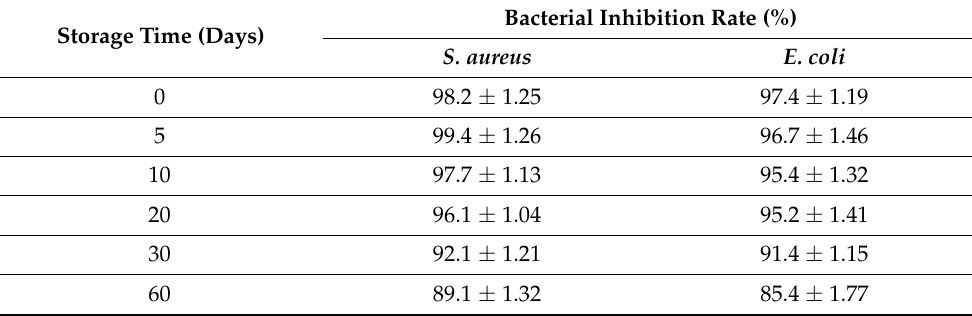
Table 7. Antibacterial activity of 100% HPMC-based CS–SiNPs-encapsulated PO-PE against Staphylo- coccus aureus (Gram-positive bacteria) and Escherichia coli (Gram-negative bacteria) [123]. Storage Time